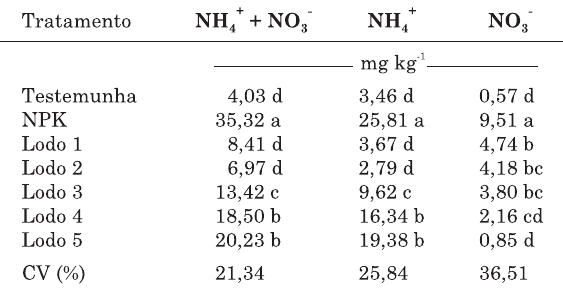
Figura 2. Análise de regressão dos teores de C microbiano no solo após a aplicação de lodo anaeróbio da estação de tratamento de efluentes da parboilização do arroz. * Significativo a 5 %. (1) Tratamento NPK incluído como referência fora da análise de regressão.